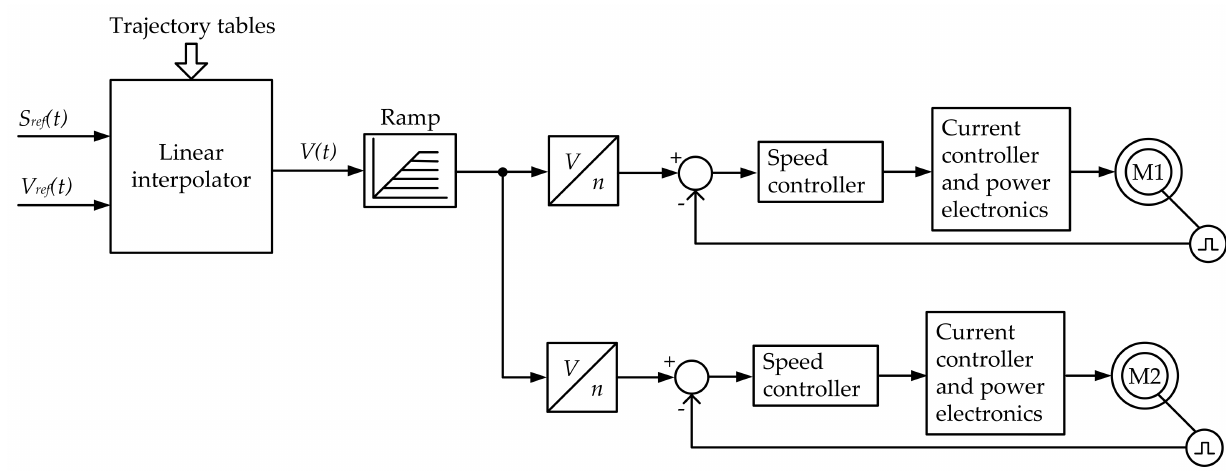
Figure 4. Block diagram of the UMD and LMD speed control system; S ref , V ref are the movement trajectory and the speed reference values; V ( t ) is the interpolator-generated electric drive speed